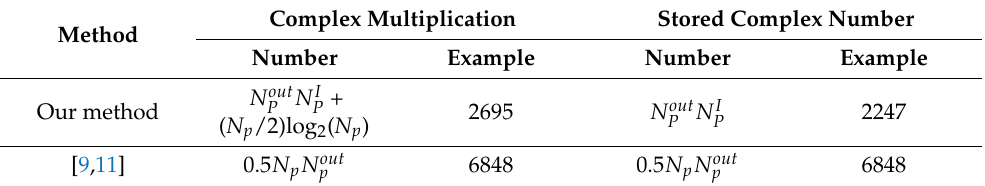
Table 5. Comparisons of different methods on computational complexity and memory resource